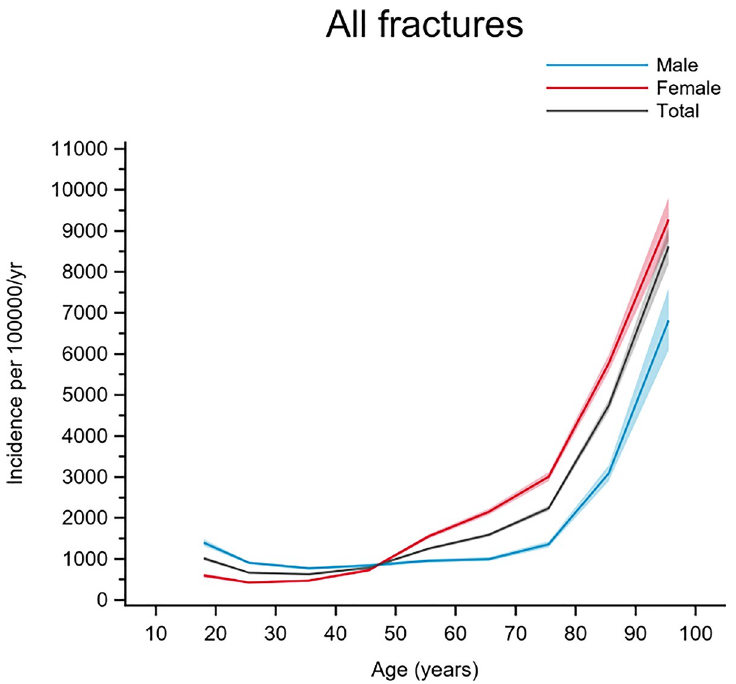
Fig 1. Age- and gender-specific incidence with 95% confidence interval of all fractures registered in the SFR over 4 years, 2015–2018. Black line represents the total population; red line represents females and blue line represents males.